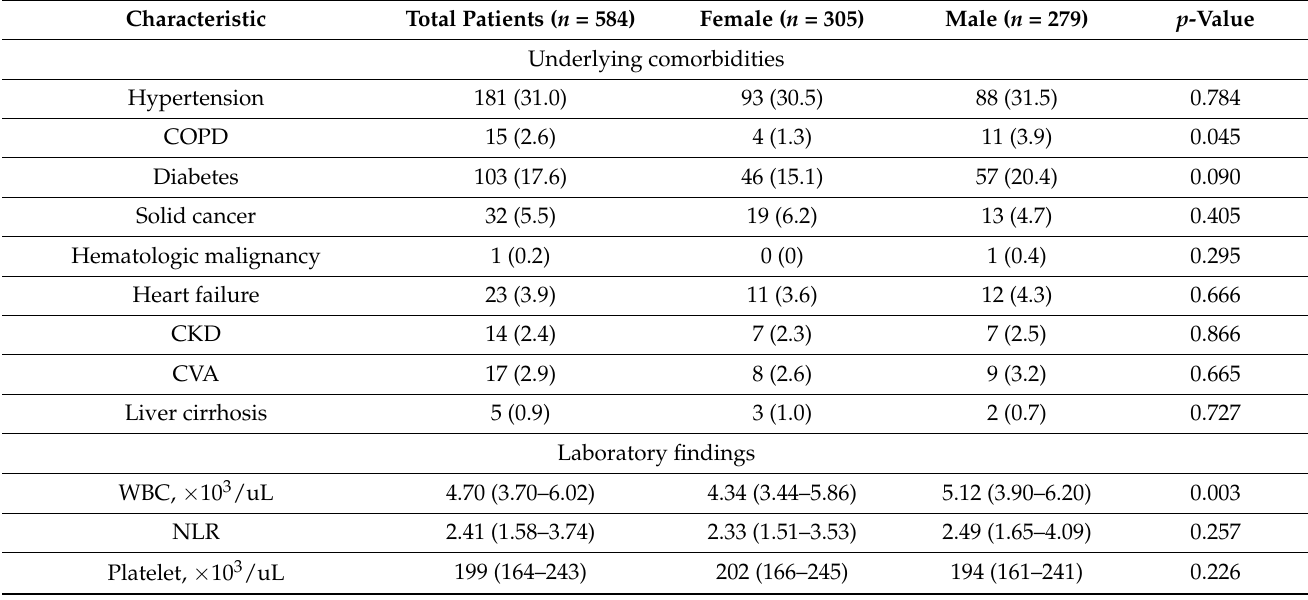
Table 2. Baseline comorbidities and laboratory findings of the study